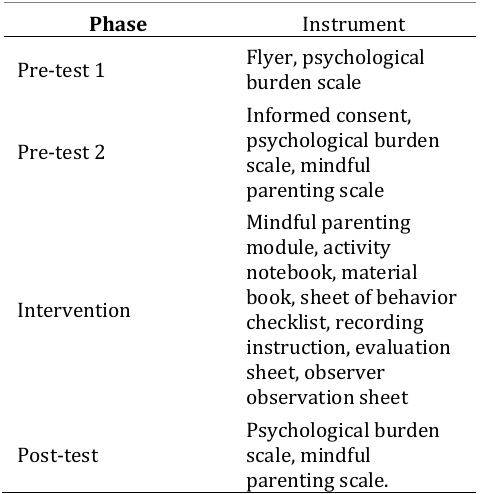
Table 1 Stages of intervention